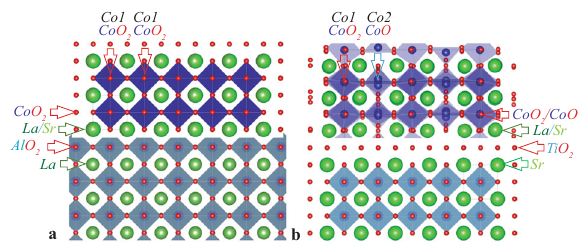
Fig. 1 Schematics of the oxygen vacancy ordering depending on the substrate used for growing LSCO thin fi lms. The cubic perovskite phase of LSCO ( a ) transforms to its Brownmillerite phase ( b ) (characterized by oxygen vacancies ordering due to the alternating octahedra (Co1 O 6 ) and tetrahedra (Co2 O 4 ) coordination of Co ions) by strain engineering.